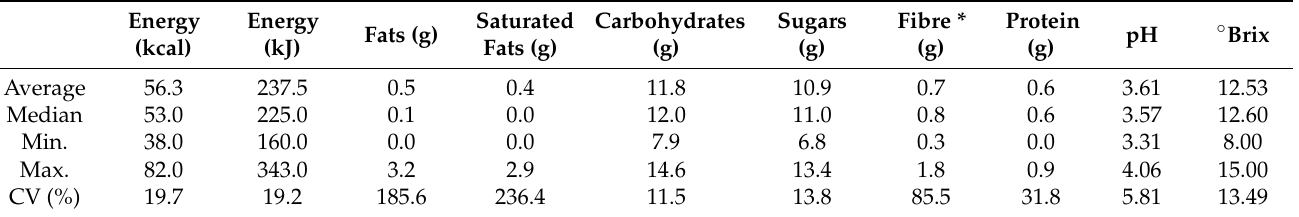
Table 1. Summary of the nutritional labelling and physical–chemical analysis of the studied smoothies per 100 mL of